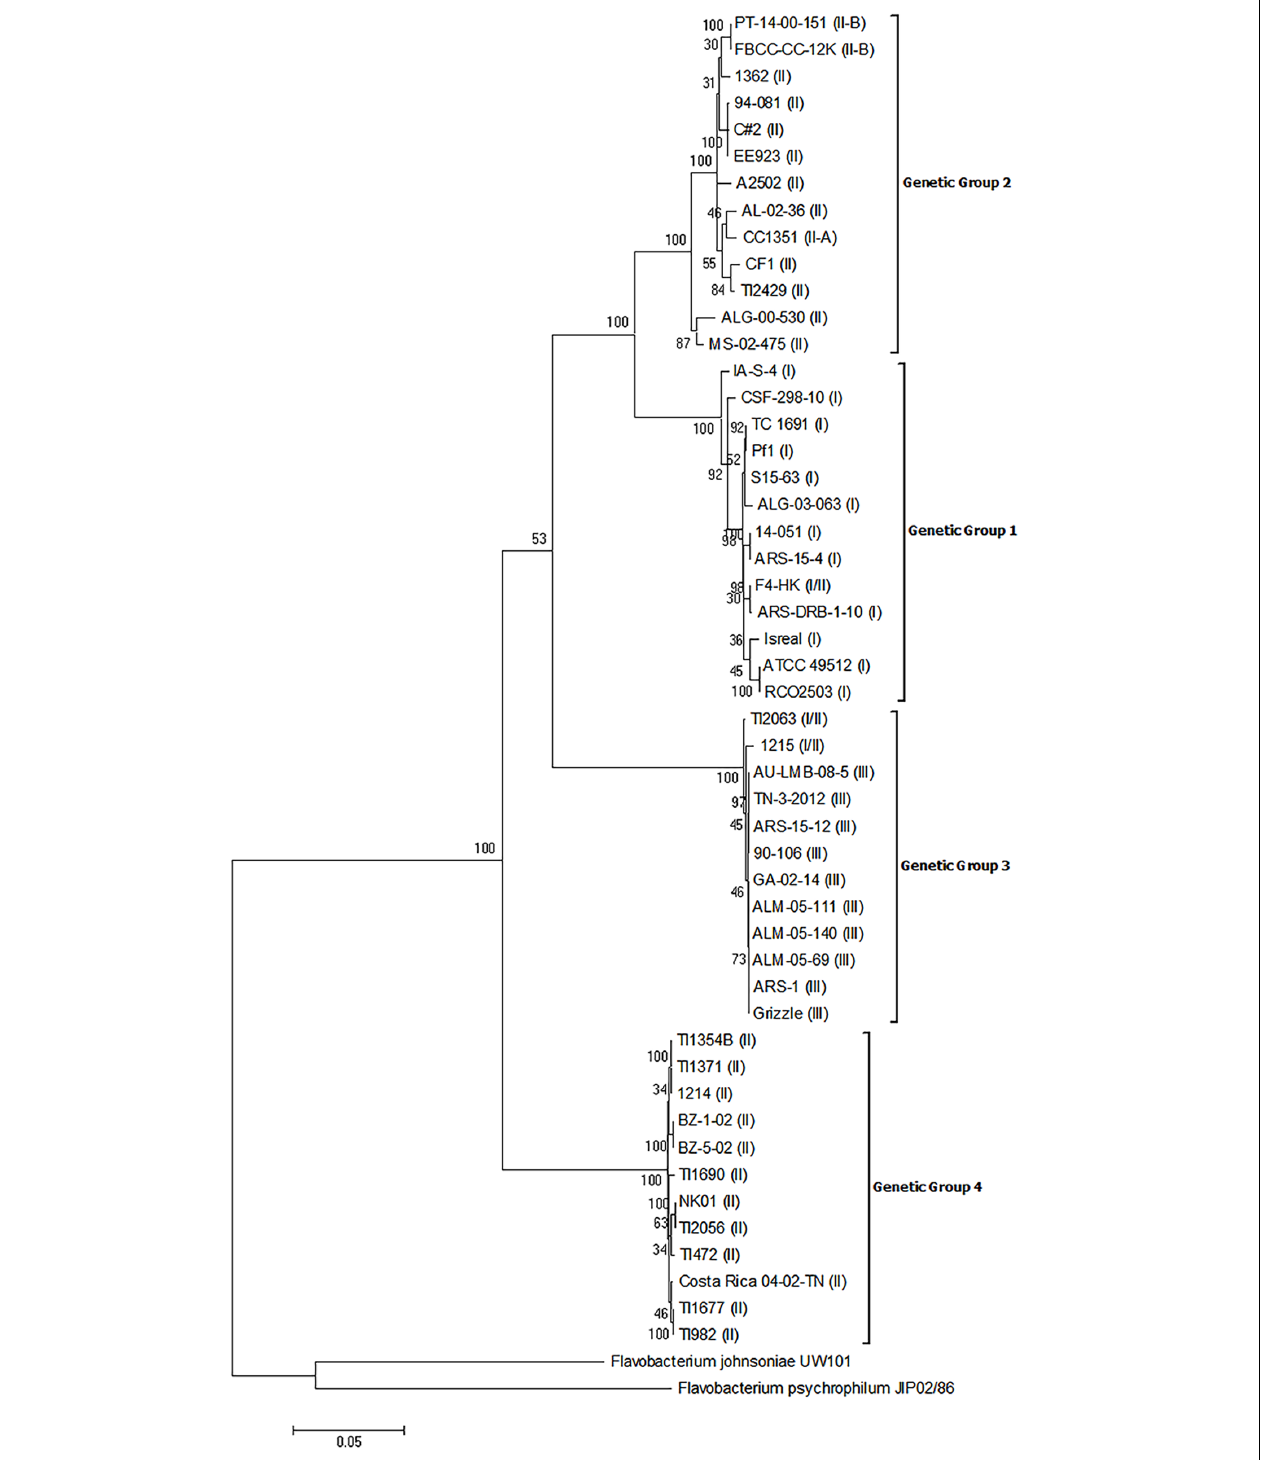
FIGURE 2 | Phylogenetic relationships based on six concatenated housekeeping gene sequences of 50 isolates of Flavobacterium columnare . Relatedness was inferred using the maximum likelihood method based upon the general time reversible model (GTR+G+I) and rooted with F. johnsoniae and F. psychrophilum . The percentage of trees in which the associated sequences clustered together in the bootstrap test (1,000 replicates) is shown next to the branches. The analysis involved 52 nucleotide sequences, all positions containing gaps and missing data were eliminated, and there were a total of 3,633 positions in the final dataset. The assigned genomovar of the isolate is in parentheses adjacent to the isolate designation.